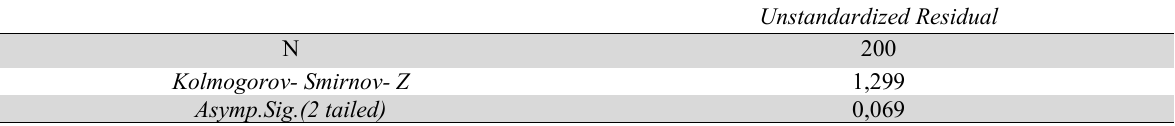
Unstandardized Residual